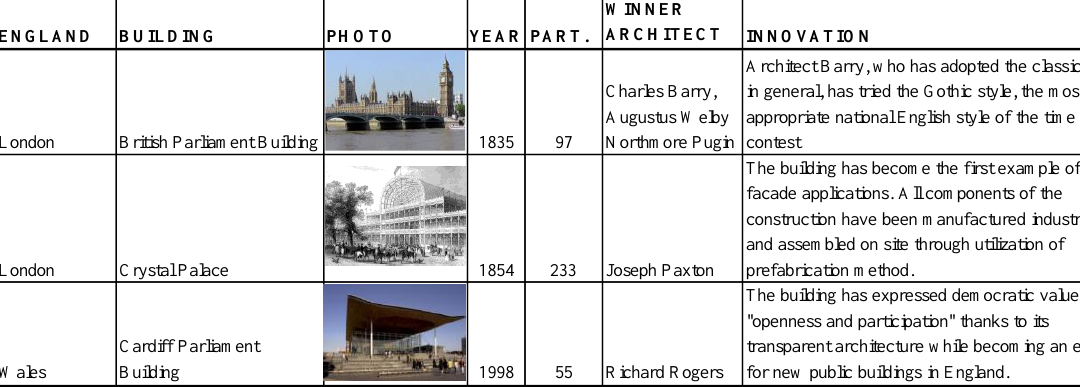
Table 2 . Selected competition examples from Germany ALMANYA